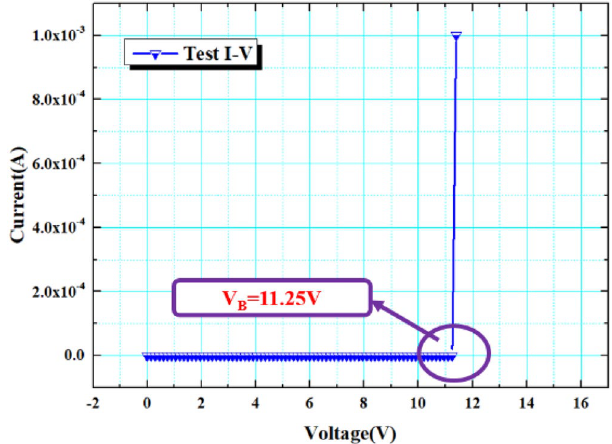
Figure 8. The test I-V curve of VADTS.